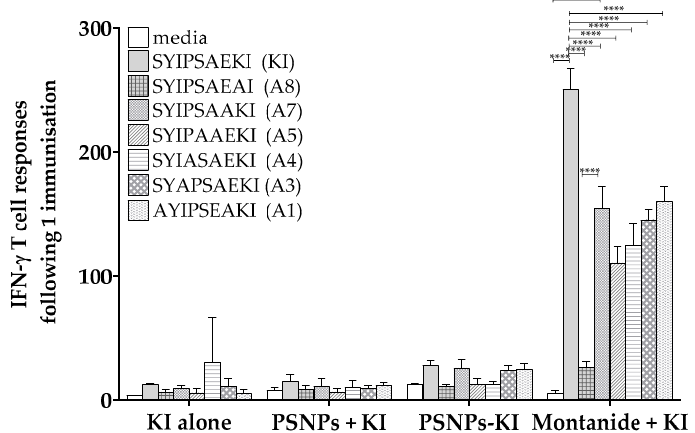
Figure 1. Moderate cross-reactivity to restimulated alanine altered variants of SYIPSAEKI. The 6–8 week old BALB / c mice were immunized once with KI peptide alone (25 µ g KI per mouse), PSNPs plus KI or KI conjugated to PSNPs (PSNPs + KI, PSNPs-KI, respectively, 25 µ g per mouse KI and 1% solids PSNPs for both groups), or Montanide plus KI (25 µ g KI per mouse in 70% / 30% v / v Montanide / Phosphate bu ff ered saline (PBS)). Two weeks after the last immunization, splenocytes from immunized mice were harvested and restimulated with altered peptides in an in vitro ELISpot assay for IFN- γ . Data shown as mean +/ - SD of spot forming units (SFU) / million cells per assay triplicates (pooled cells from 3–4 mice per group). * p < 0.05, ** p < 0.01, *** p < 0.001, **** p <